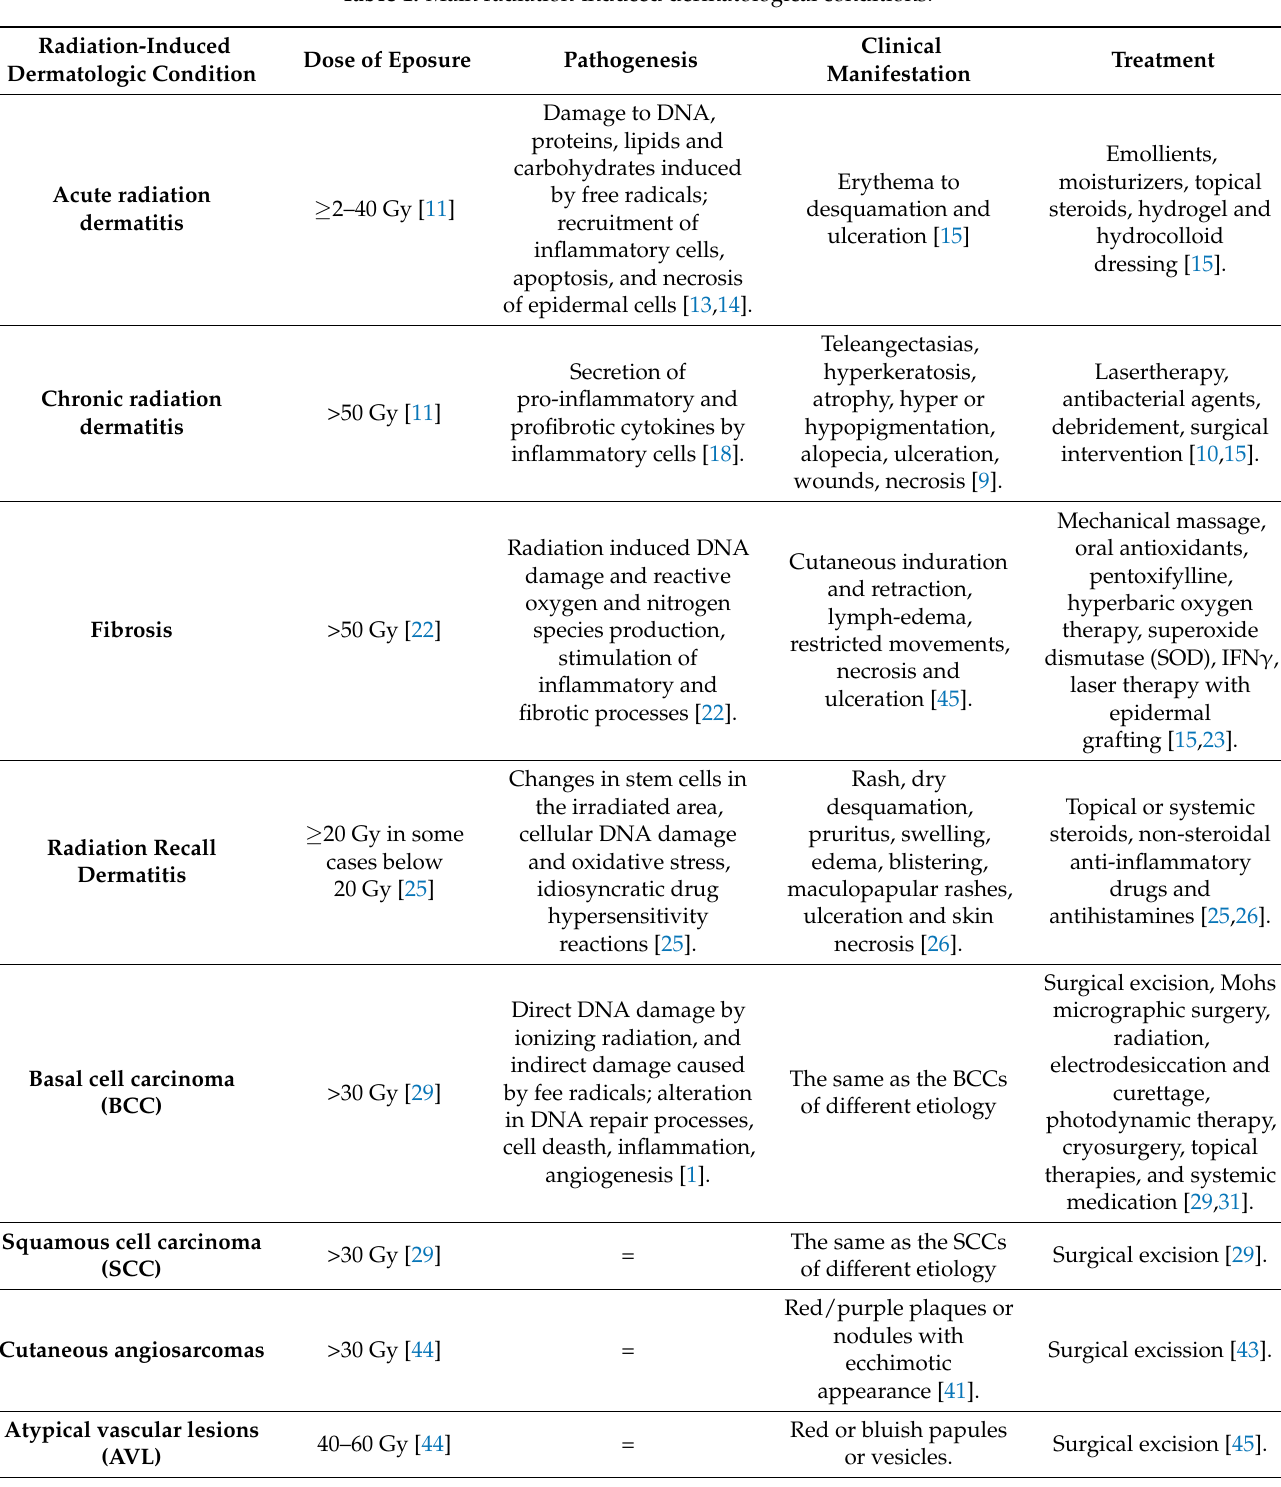
Table 1. Main radiation-induced dermatological